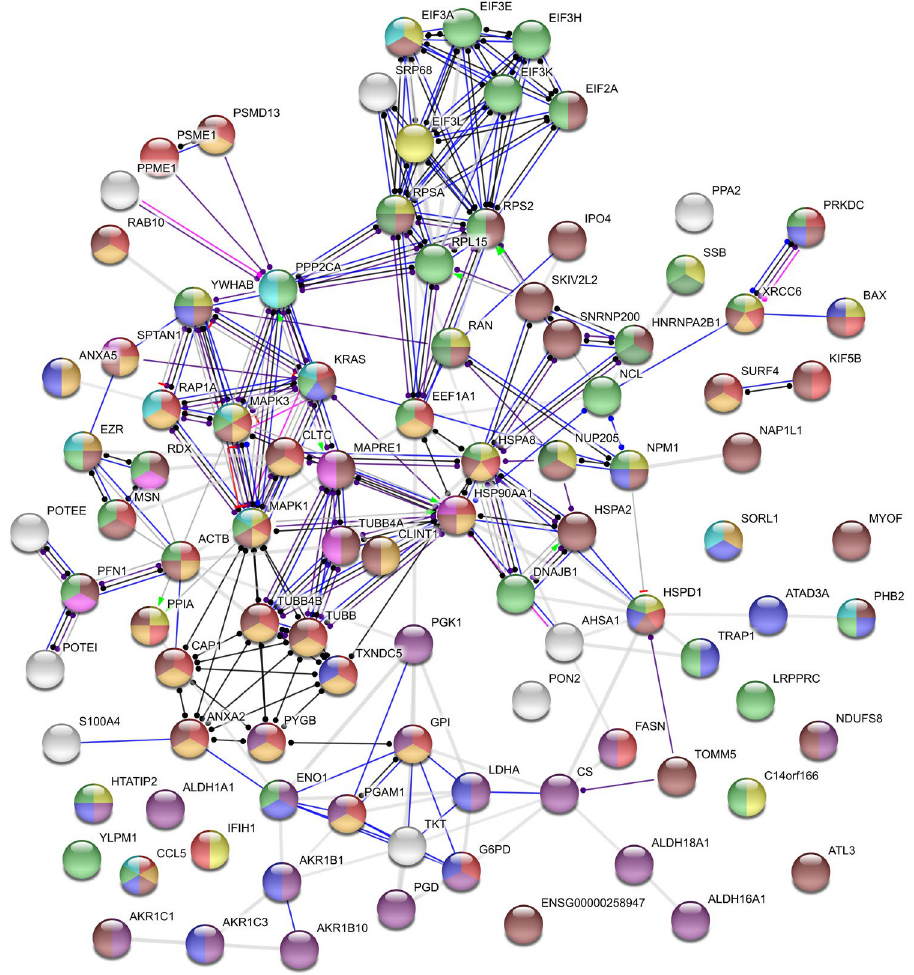
Figure 5. Interaction between proteins putatively mediating binase antiviral activity in IAV-infected cells as generated by STRING. Proteins are represented as nodes, and their functional links are defined by solid lines at high confidence (interaction score above 0.7). Circles are colored according to biological process gene ontology: yellow—viral process (GO:0016032), red—immune system process (GO:0002376), blue—the regulation of cell death (GO:0010941), green—ribonucloprotein complex export from the nucleus (GO:0071426), pink—the regulation of protein polymerization (GO:0032271), light blue—regulation of the MAPK cascade (GO:0043408), light green—the regulation of gene expression (GO:0010468), orange—vesicle-mediated transport (GO:0016192), purple—oxidation-reduction process (GO:0055114), and brown—cellular component organization or biogenesis (GO:0071840).